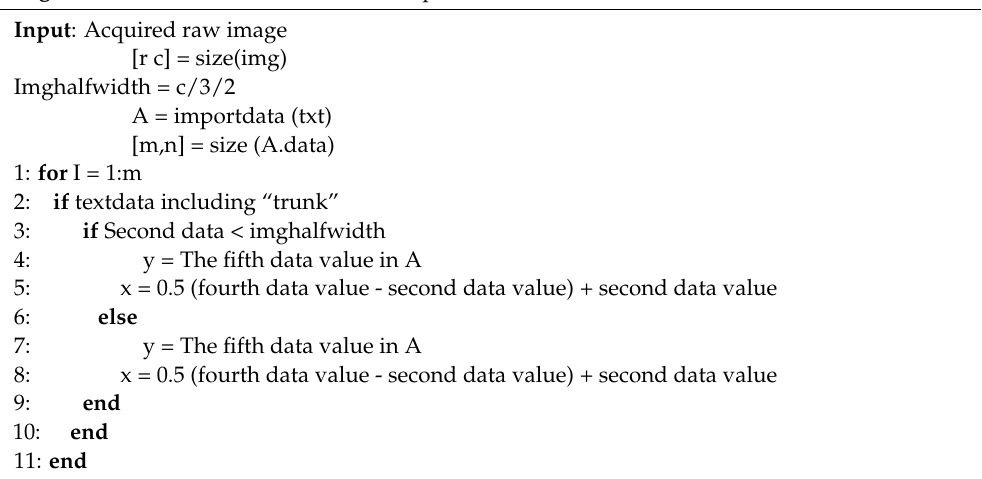
Algorithm 1 Obtain available coordinate points